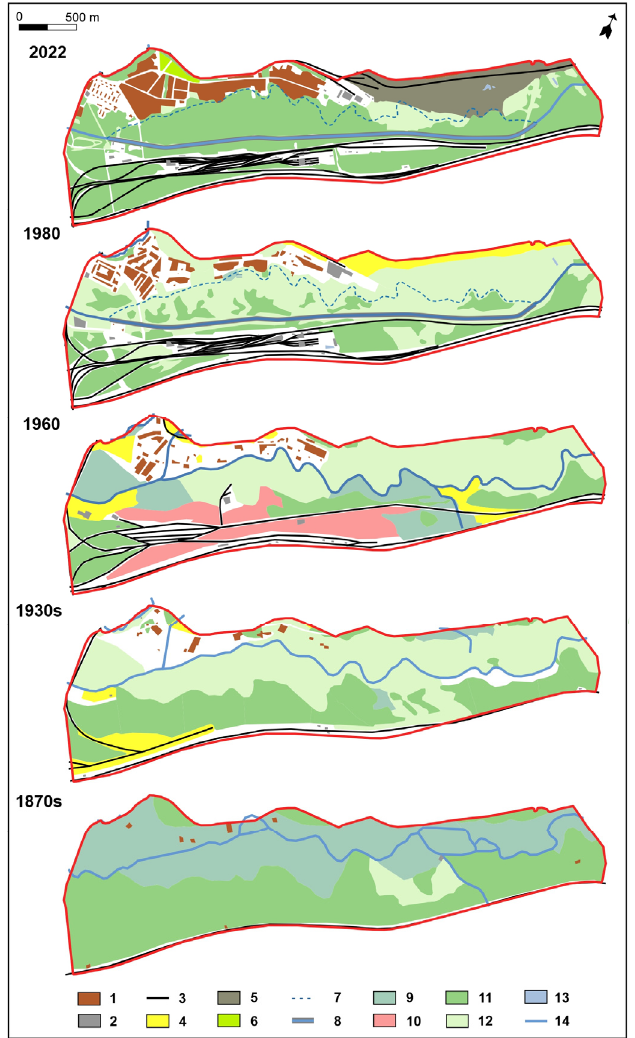
Figure 3. Land use/cover and vegetation changes in the period of 1870 to 2022: 1—buildings,